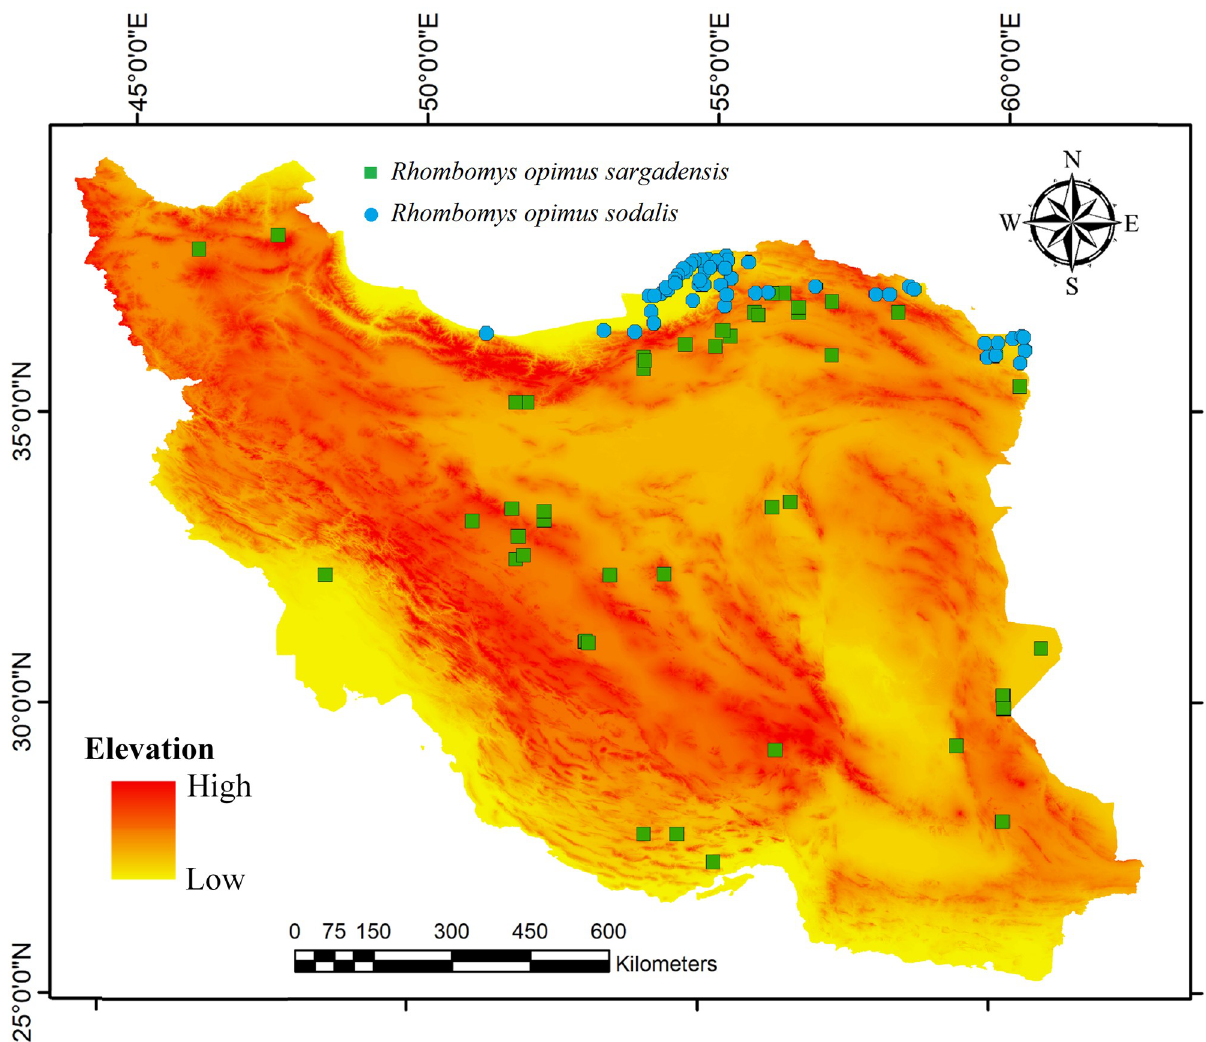
Fig 2. Point localities map of Rhombomys opimus . Known localities for R . o . sargadensis and R . o . sodalis are shown as green squares and blue circles, respectively.